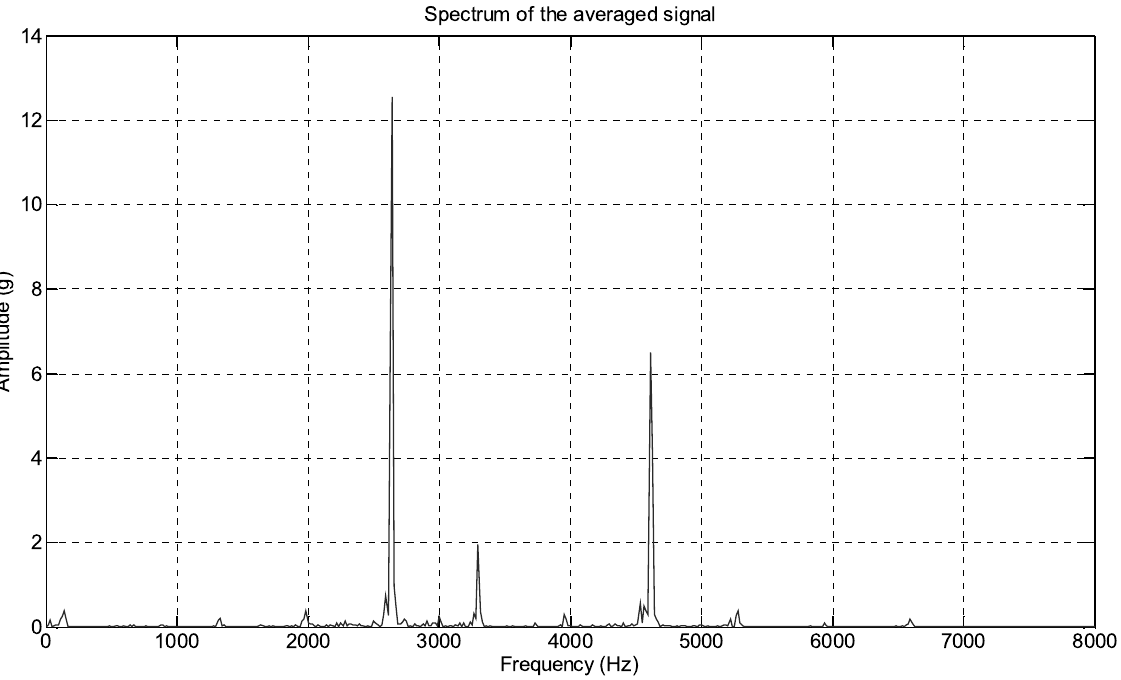
Fig. 19. Frequency spectrum for the 20%